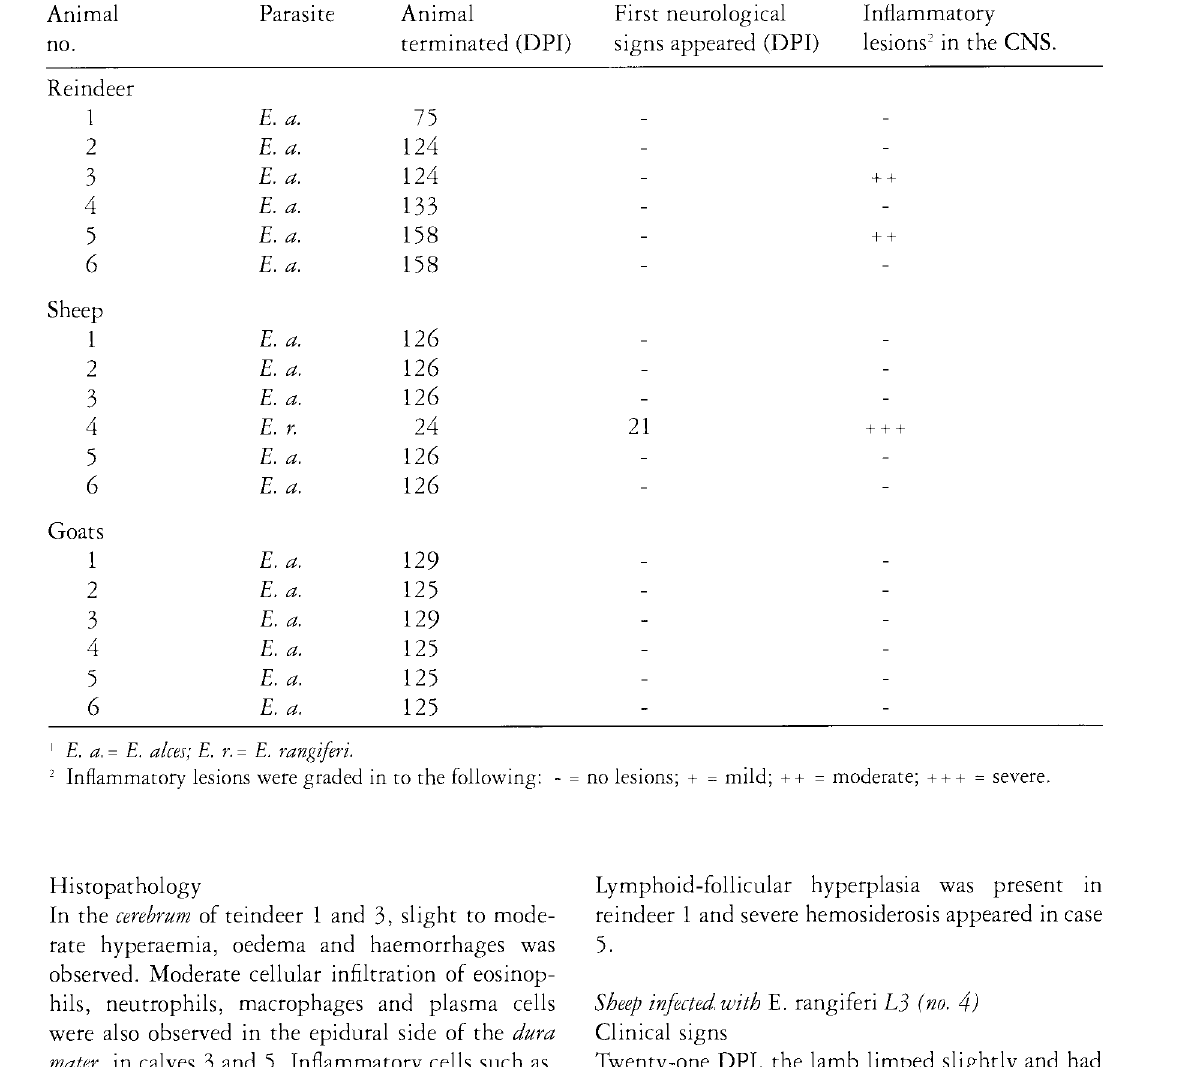
Table 1. Experimental infection of sheep, goats and reindeer {Rangifer tarandus) with Elaphostrongylus' spp. from moose (Alces alces) and reindeer respectively. All animals received an estimated dose of about a thousand L3 larvae. Animal Parasite Animal First neurological Inflammatory no. terminated (DPI) signs appeared (DPI) lesions 2 in the CNS.